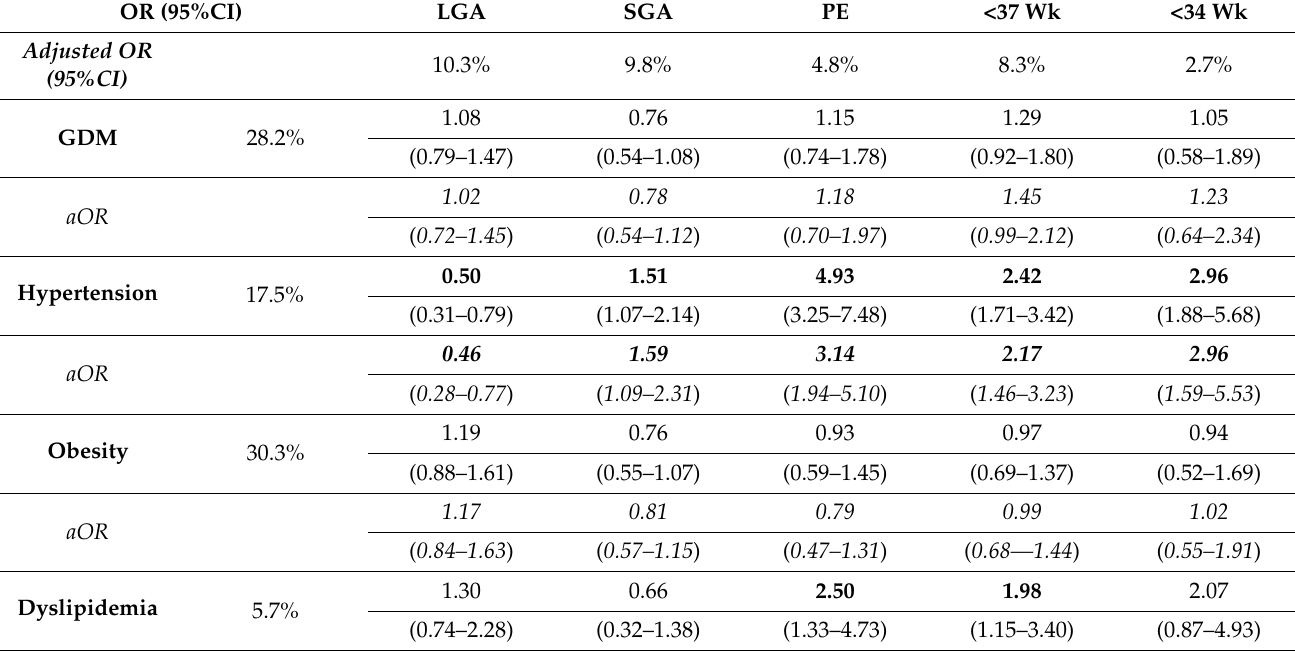
Table 3. Adjusted odds ratios of LGA, SGA, PE, <37 wk and <34 wk gestational age at birth of the different present conditions at OGTT (GDM, hypertension, obesity, dyslipidemia, and proteinuria, and having ≥ 2 constituents of the metabolic syndrome. Adjustments were made for the